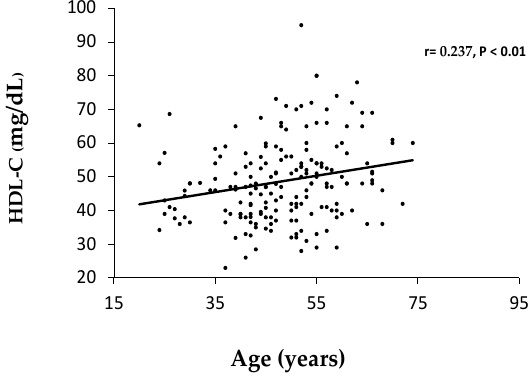
Figure 1. Correlation between age and HDL cholesterol in pre ( n = 100) and postmenopausal ( n = 88) women.